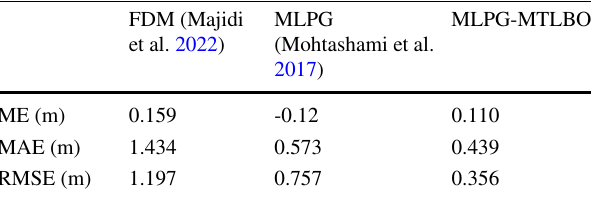
Table 6 Computation of error criteria for different methods FDM (Majidi et al. 2022)